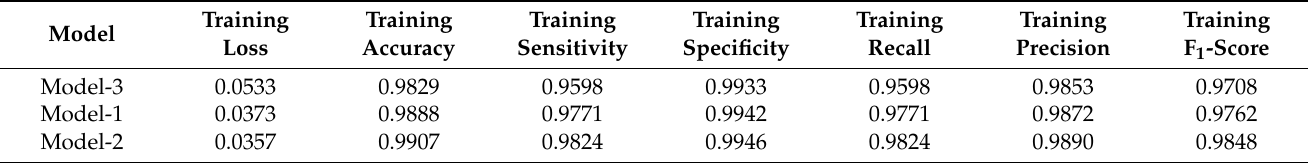
Table 3. Training results of the models used in the